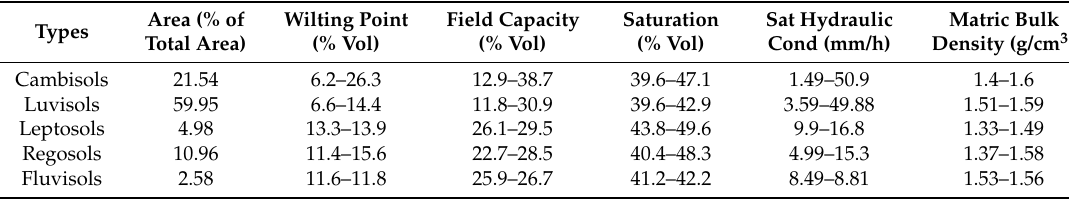
Table 1. Hydrological properties of the soil